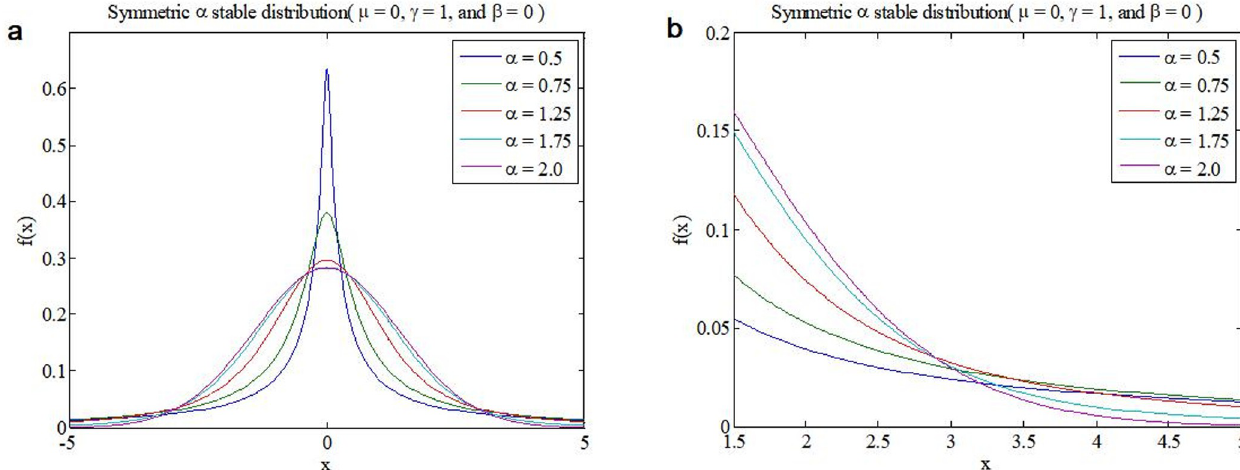
Fig 1. PDFs of S α S stable distribution under α = 0.5, 0.75, 1.25, 1.75 and 2.0. (a. Full PDFs diagram; b. Local trailing PDFs diagram).